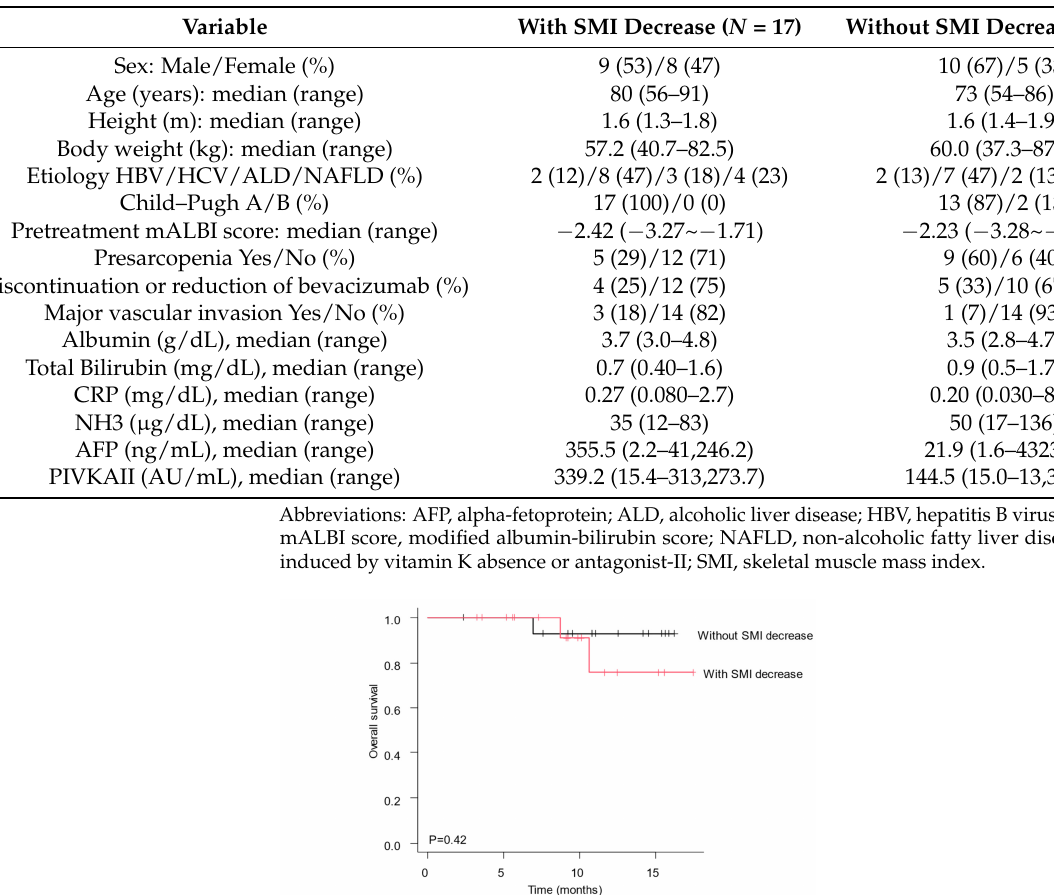
Figure 2. Percent change in SMI during atezolizumab plus bevacizumab. Table 2. Baseline characteristics of the patients with or without SMI decrease.